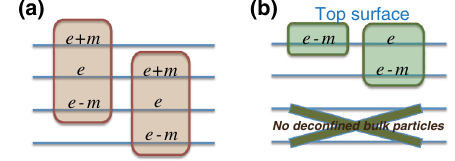
FIG. 2. (a) Illustration of the condensation of the composite particle of e þ m , e , and e − m in three consecutive layers, with each layer a Z toric code state. (b) For p ≡ 1 ; 2 mod 3 , there is no p deconfined particle in the 3D bulk. The deconfined particles only stay on the surface, which is generated by two elementary particles shown in the green regions. (The case of p ≡ 0 mod 3 is discussed later in Fig.